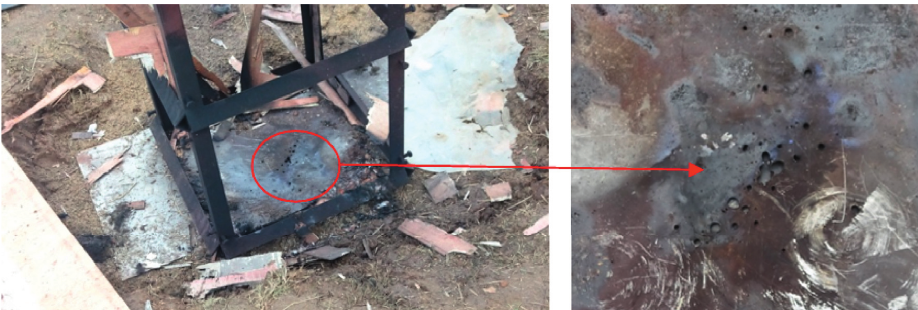
Figure 17: Experimental result of penetrating 10mm after-effect